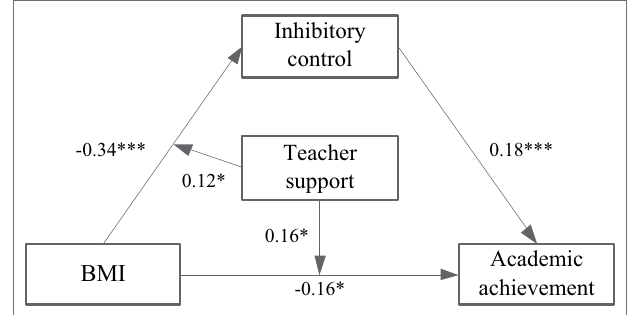
FIGURE 3 | A moderated mediation model of the teacher support. *The correlation is significant at the 0.05 level. ***The correlation is significant at the 0.001